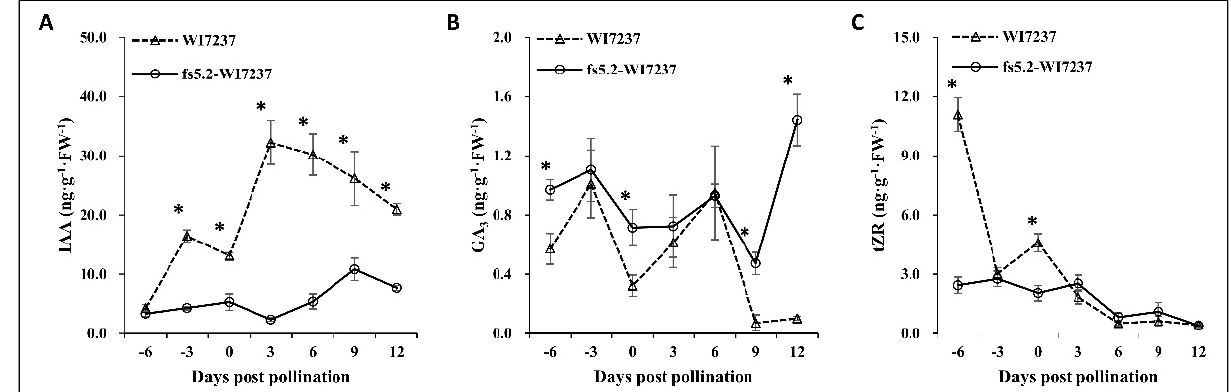
Figure 4. Dynamic change of endogenous phytohormones IAA/auxin ( A ), GA 3 (active GA, ( B )), and tZR (active cytokinin, ( C )) at different ovary/fruit development stages in NIL fruits. Asterisks (*) indicate significant differences between WI7237 and fs5.2-WI7237 at p < 0.05 based on t -tests.